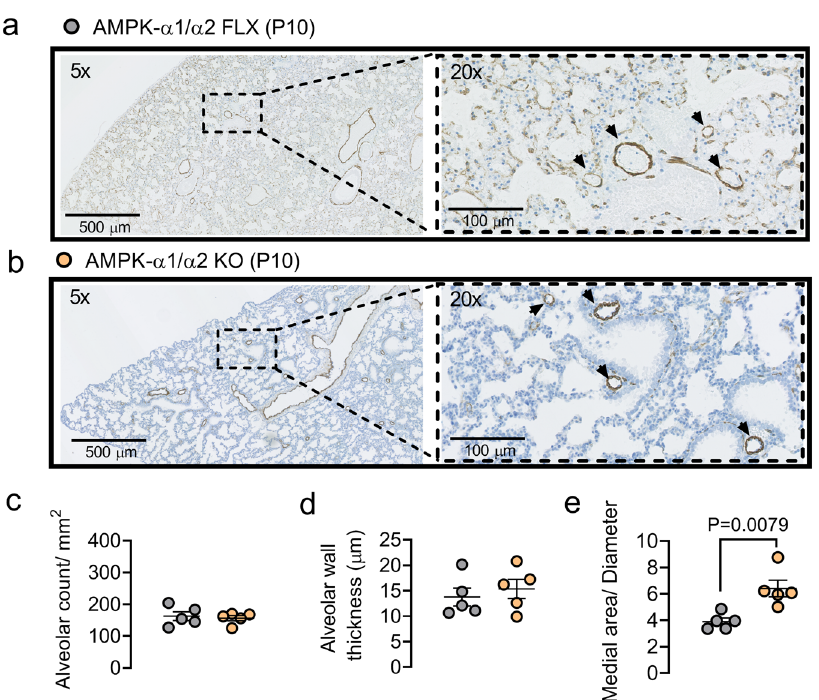
Fig. 5 | In neonatal lungs AMPK- α 1/ α 2 deletion has no effect on alveolar number or wall thickness but increases medial thickness of pulmonary arteries. Representativeimagesofalveoliinlungslicesfromnon-terminalsamples stained for α -smooth muscle actin from ( a ) age-matched AMPK- α 1/ α 2 fl oxed (AMPK- α 1/ α 2 FLX) controls and ( b ) AMPK- α 1/ α 2 KOs. Scatter plots show ( c ) alveolar numberper mm 2 ( n =5mice pergenotype, averaged from 2mm 2 areaper